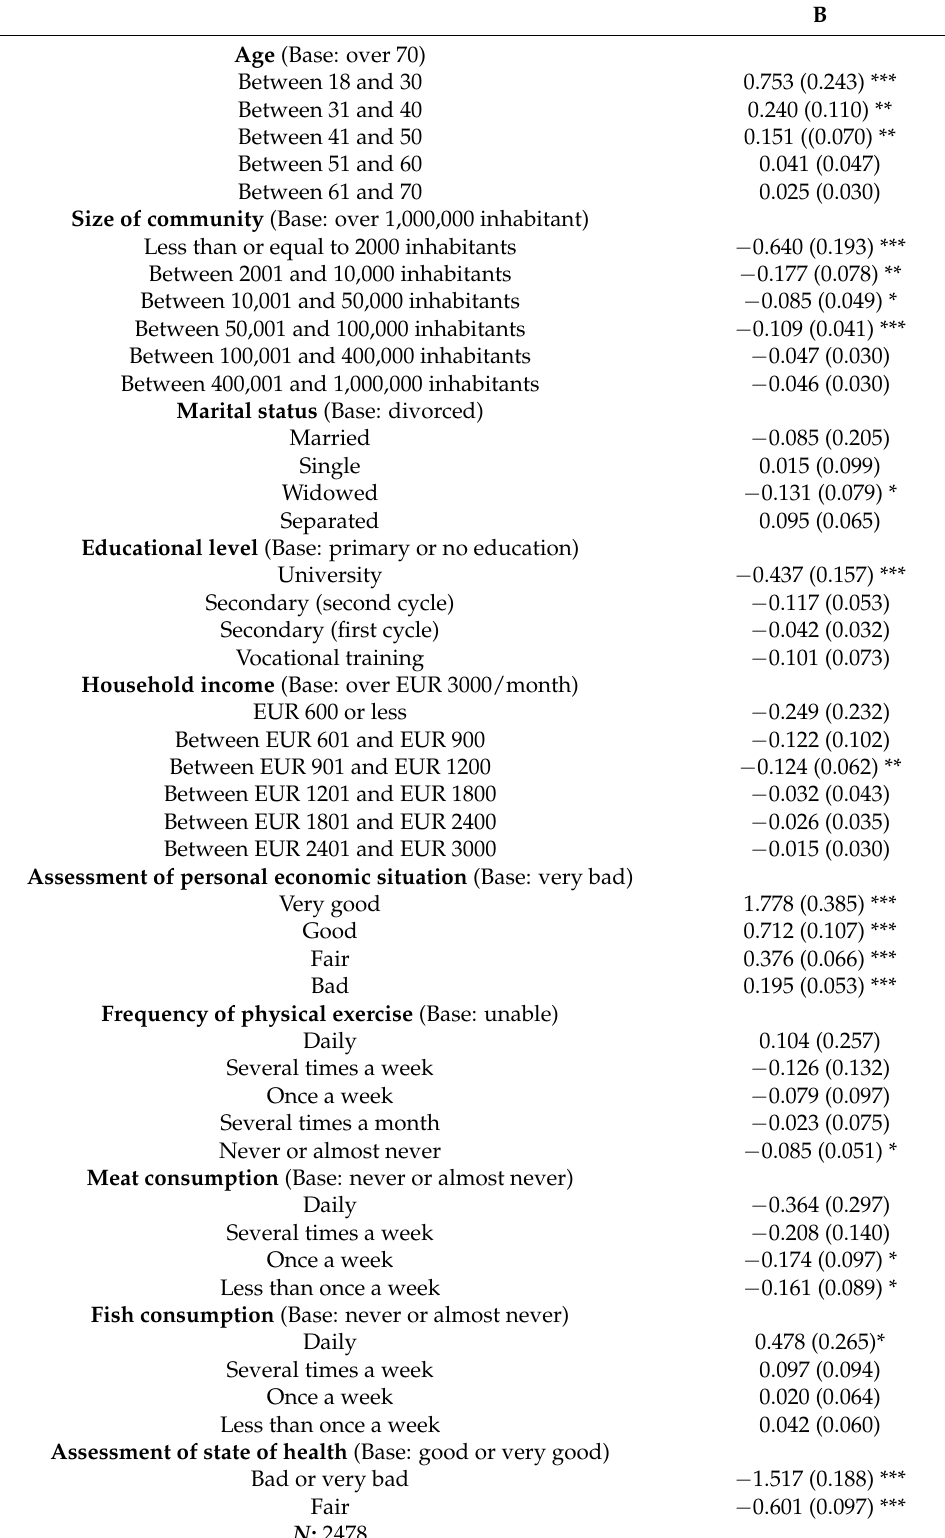
Table 5. Multiple linear regression. Scale for happiness